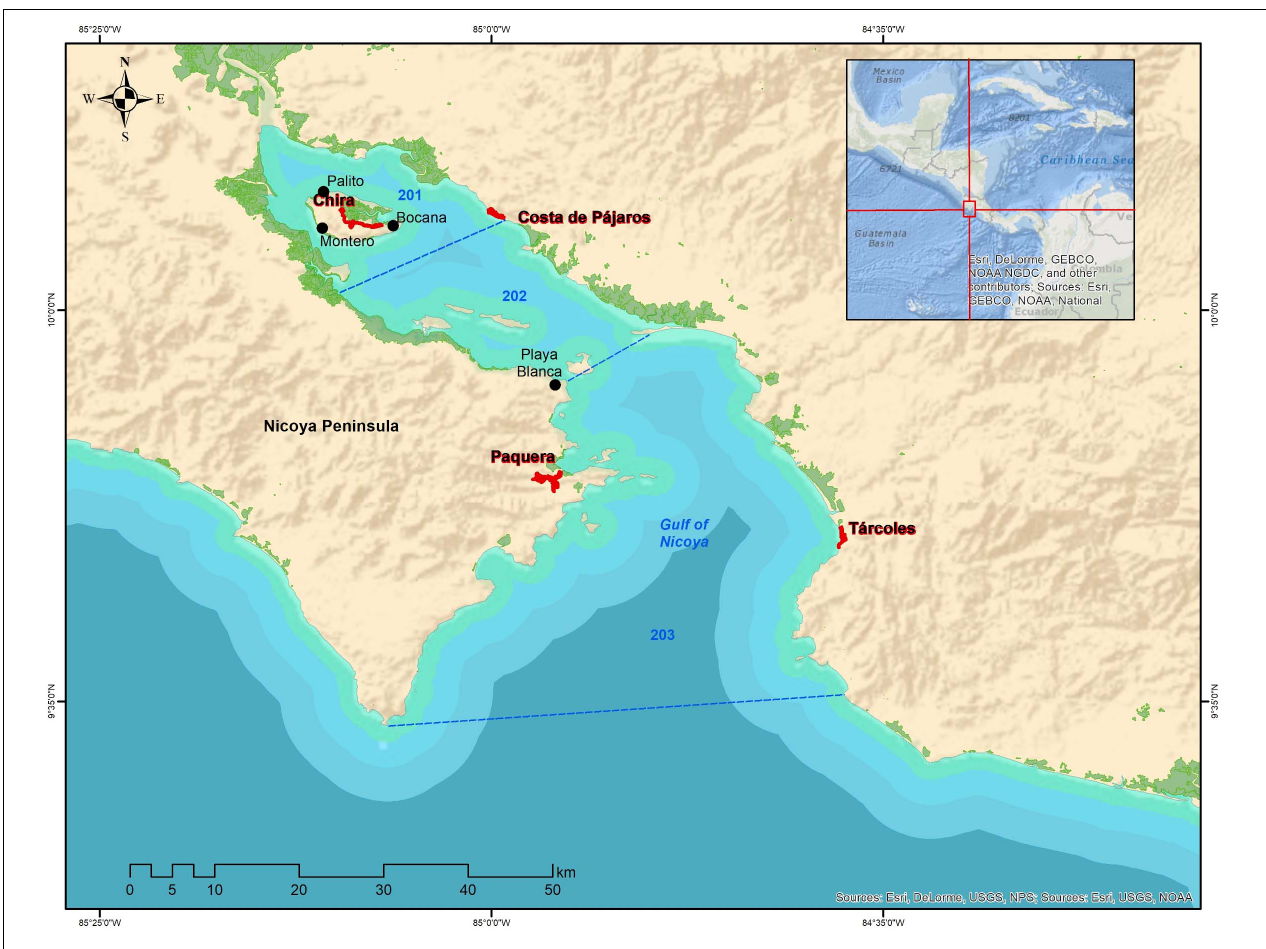
FIGURE 2 | Gulf of Nicoya located on the Pacific coast of Costa Rica. The Gulf is sectored by INCOPESCA into areas 201, 202, and 203 based on species composition and fishing gears used (Marín-Alpízar and Alfaro-Rodríguez, 2019). The four focal points selected for this study are highlighted in the figure.